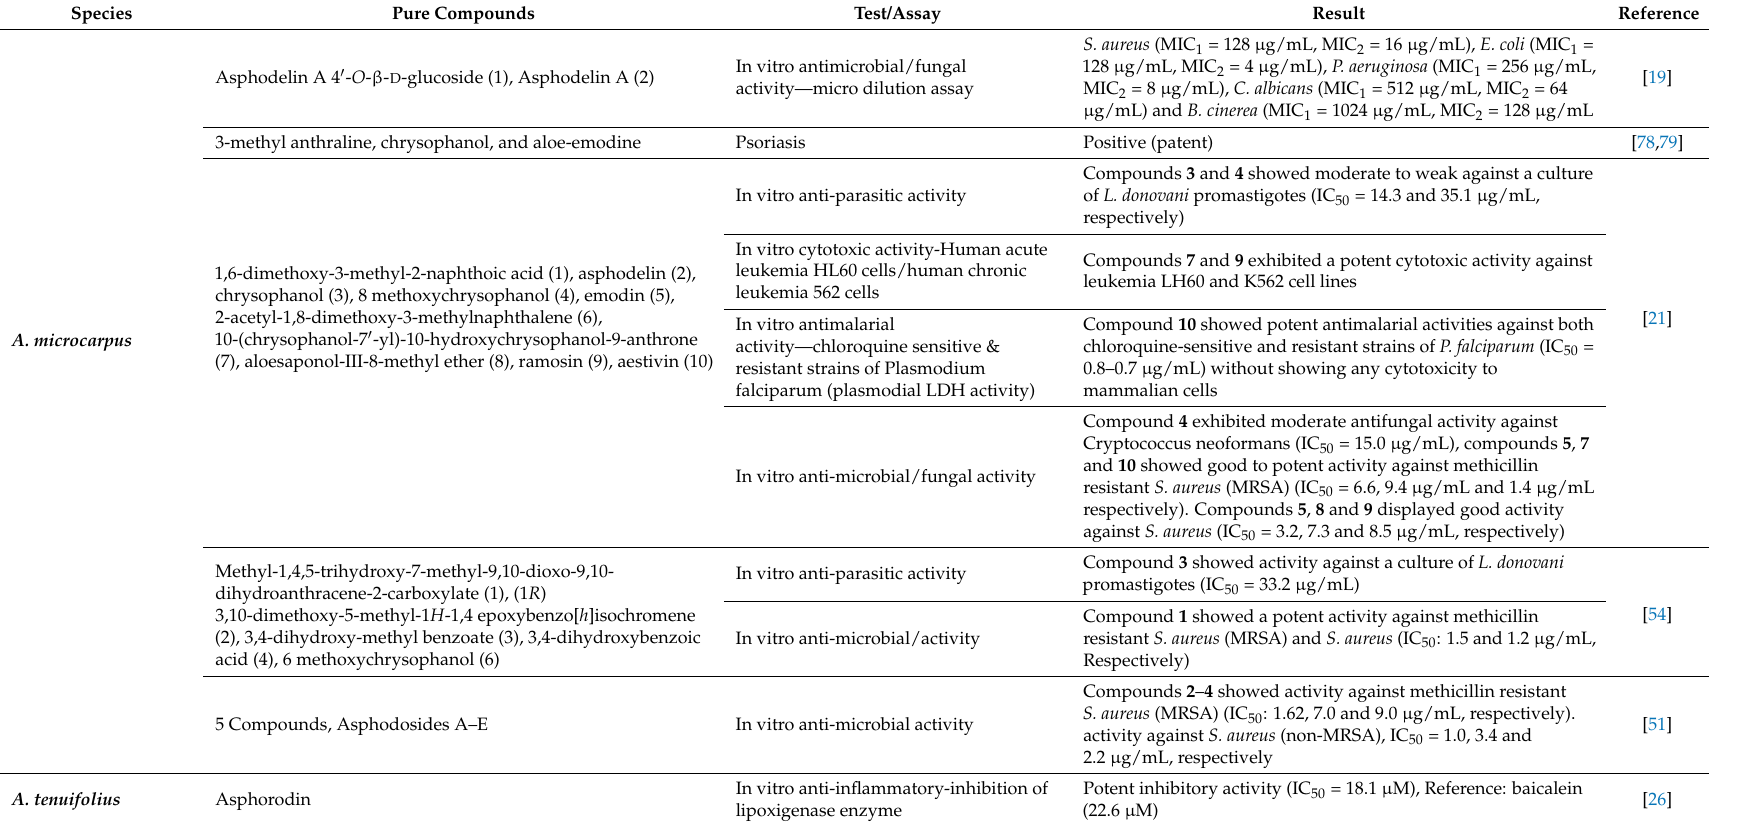
Table 4. In vitro and in vivo biological studies reported from pure compounds isolated from Asphodelus